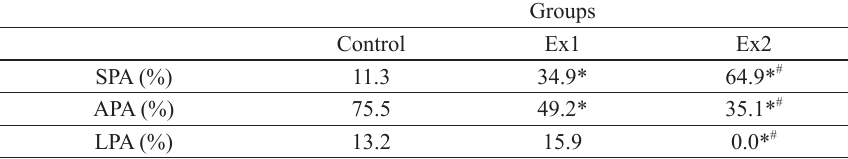
Classification of the body weight gain of newborns from SPA control, Ex1 and Ex2 dams.